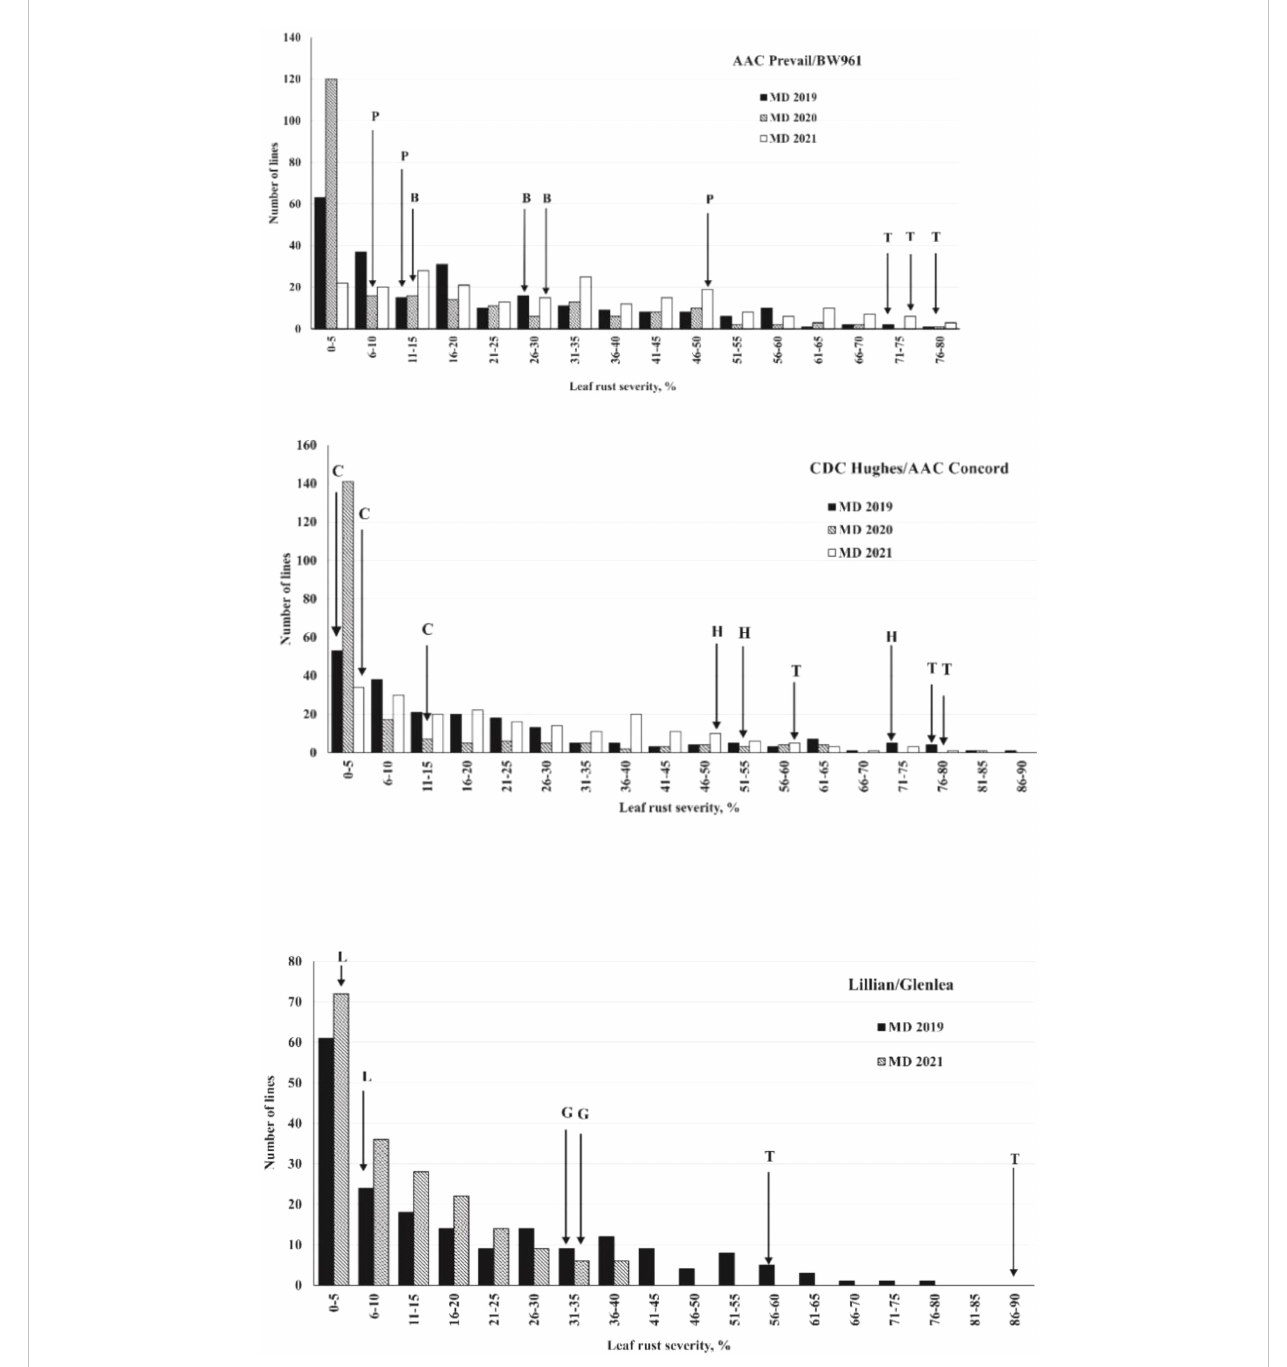
FIGURE 2 Frequency distribution of leaf rust severity for lines derived from spring wheat crosses AAC Prevail/BW961, CDC Hughes/AAC Concord, and Lillian/ Glenlea. Cultivar or line name abbreviations: L, Lillian; G, Glenlea; P, AAC Prevail; B, BW961; C, AAC Concord; H, CDC Hughes; T,